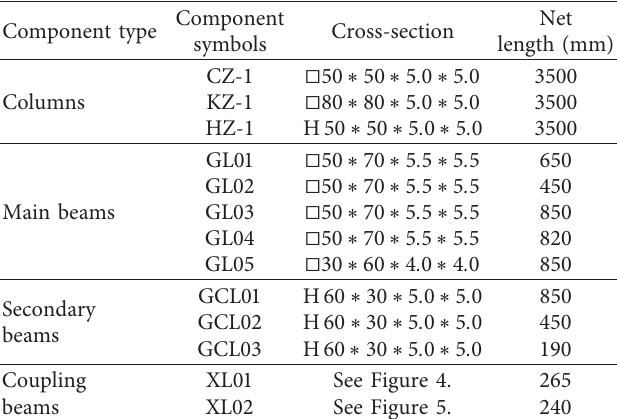
Table 4: Sections of the steel components.